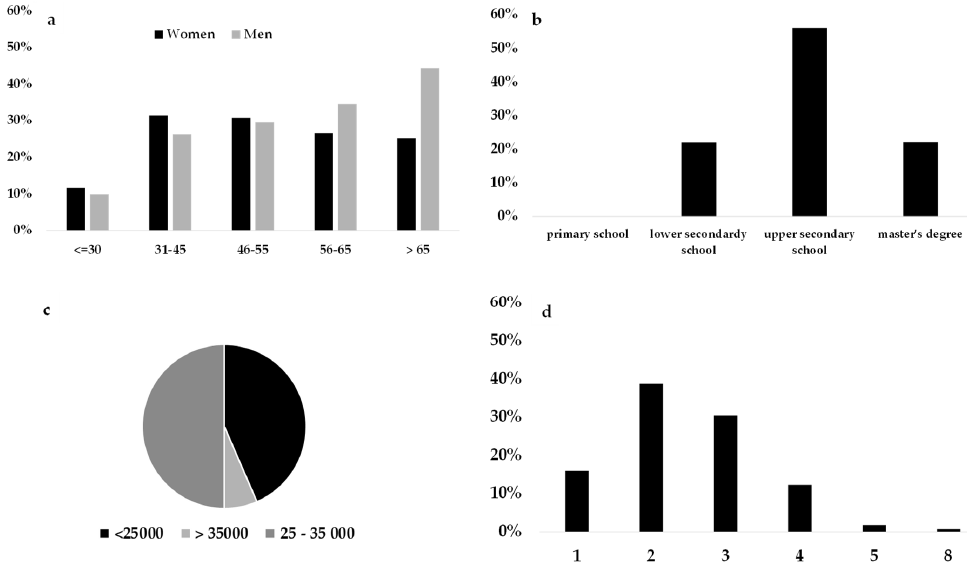
Figure 1. Sociodemographic characteristics of consumers belonging to the proposed loyalty cluster: ( a ) Gender and age group proportions, ( b ) educational level, ( c ) annual average income, and ( d ) number of family components.